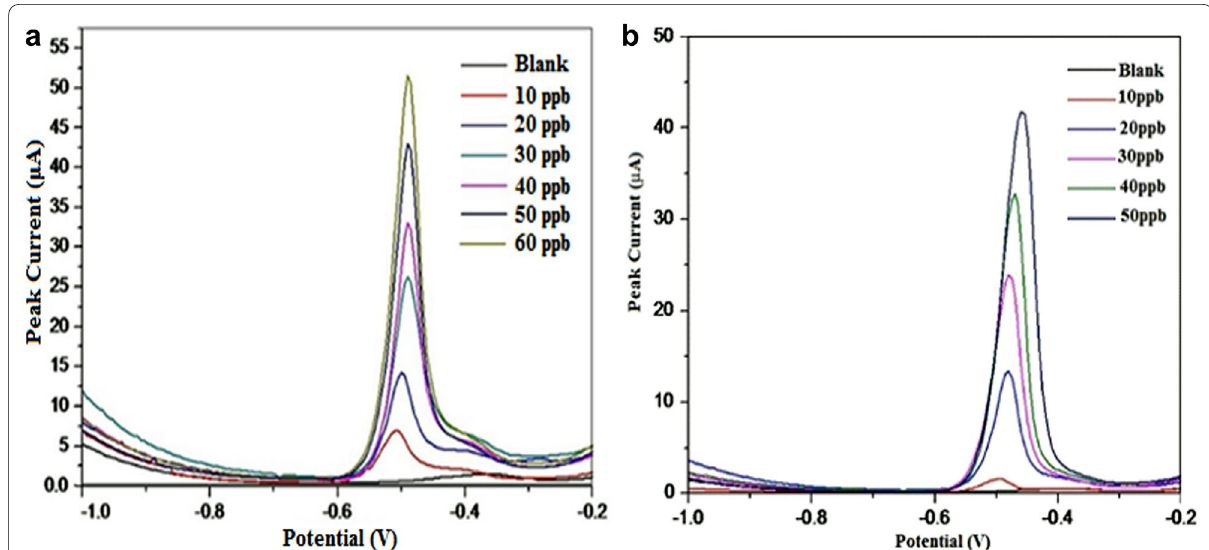
Fig. 3 Cellulose-HAp-CME stripping voltammograms for Pb(II) ion detection in a digested blood serum (reproduced from Ajab et al. 2018, with permission from Elsevier), b digested POME (reproduced from Ajab et al. 2019, with permission from